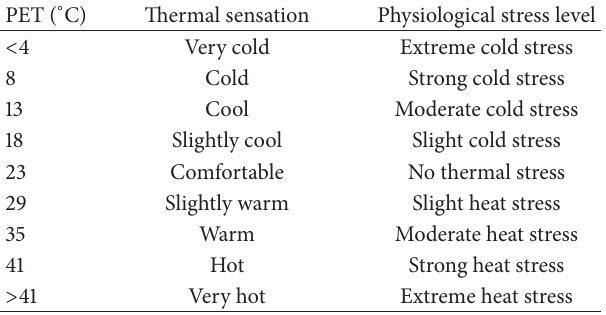
Figure 1: The Greater Athens Area (GAA) along with the examined monitoring site of Galatsi. Table 1: Physiologically equivalent temperature (PET) for different grades of thermal sensation and physiological stress on human beings (during standard conditions: heat transfer resistance of clothing: 0.9 clo, internal heat production: 80 W) [41].